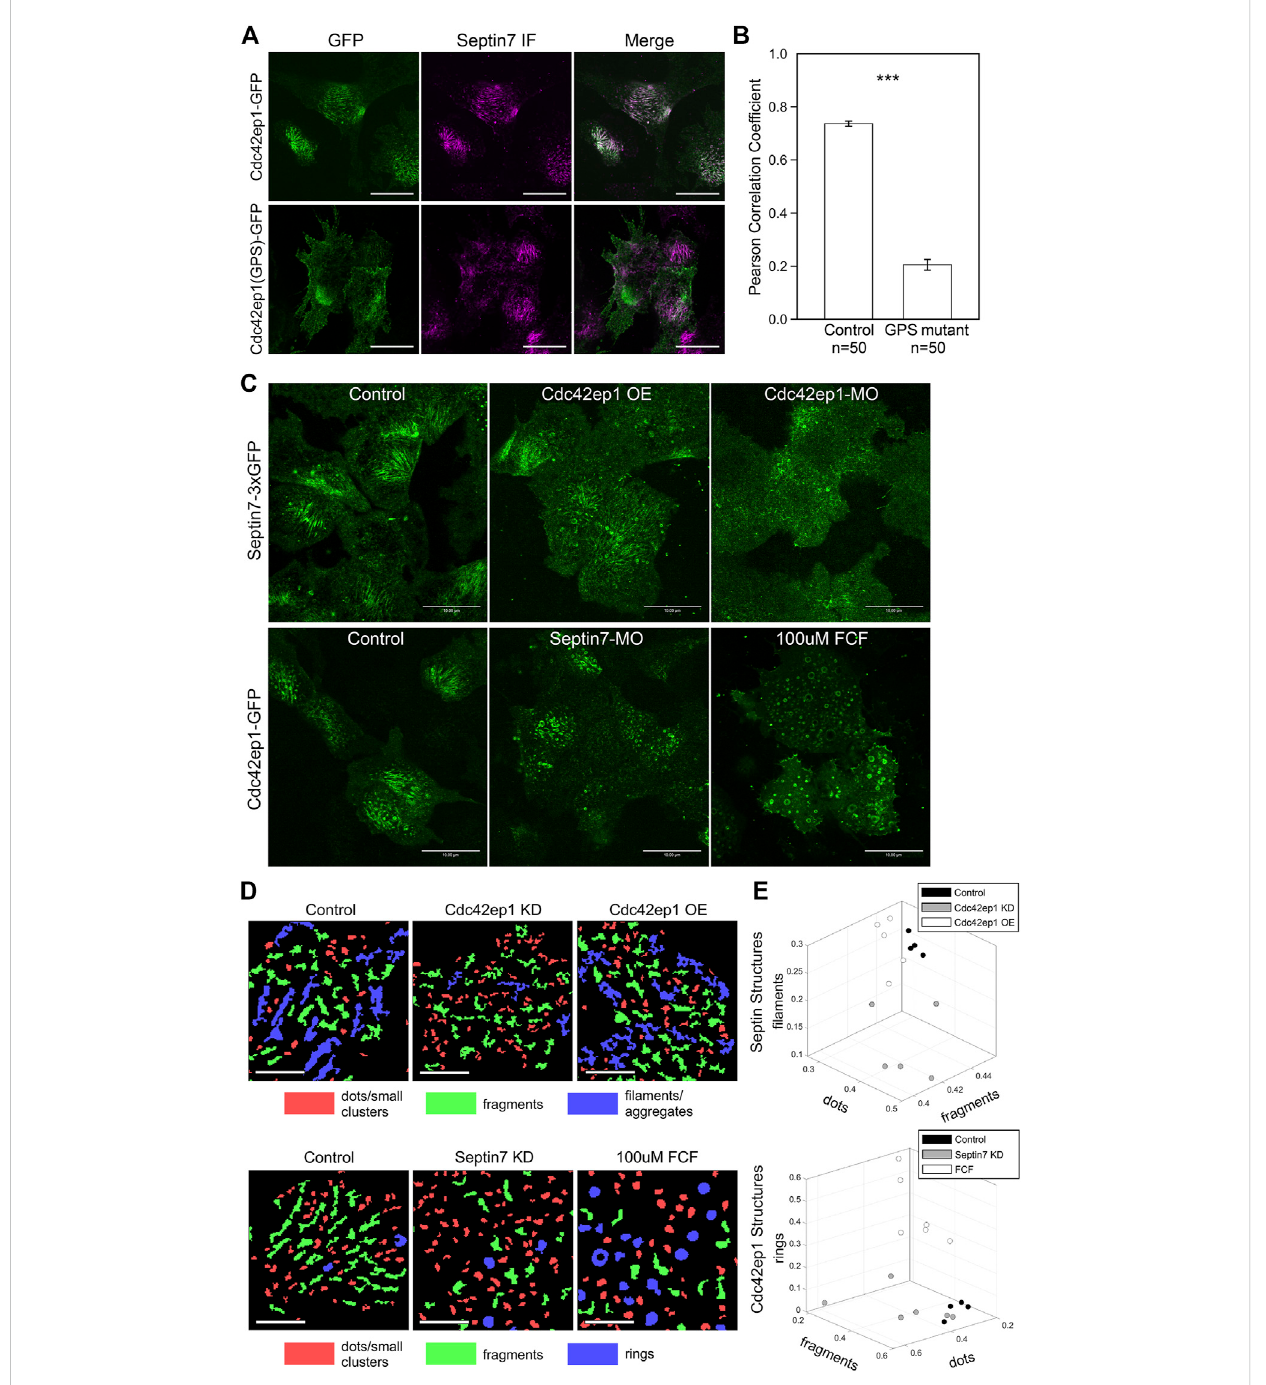
FIGURE 4 Cdc42ep1colocalizeswithseptin fi lamentsandinteractswithseptin fi lamentsinareciprocalmanner. (A) WildtypeCdc42ep1,nottheseptinbinding defective mutantform ofCdc42ep1, colocalizes withseptin fi laments in neural crestcells. (B) Correlationcoef fi cient ofCdc42ep1 andSeptin7.Thereisa signi fi cantdecreaseinthecorrelationcoef fi cientbetweenseptinbindingdefectiveCdc42ep1andseptin fi laments.Errorbars,standarderrorofthemean. ***, p < 0.001. (C) Misexpression of Cdc42ep1 disrupted the organization of septin fi laments, while septin inhibition affected the cell center localization and organization of Cdc42ep1. Given that control-MO or ethanol treatment does not affect septin fi lament (Supplementary Figure S1), untreatedcellsareusedascontrolhere.Scalebar=10 µm. (D) SeptinandCdc42ep1structureswereclassi fi edintothreemajorgroups(see Materialsand methods andSupplementaryFiguresS4,S5).Thethreegroupsofstructureswerepseudo-color-codedinexampleimages.Scalebar=5 µm. (E) Thearea fraction of structures in the three identi fi ed classes was plotted. Phenotypic distinction between different experimental manipulations were observed, demonstrating distinct effects from different experimental